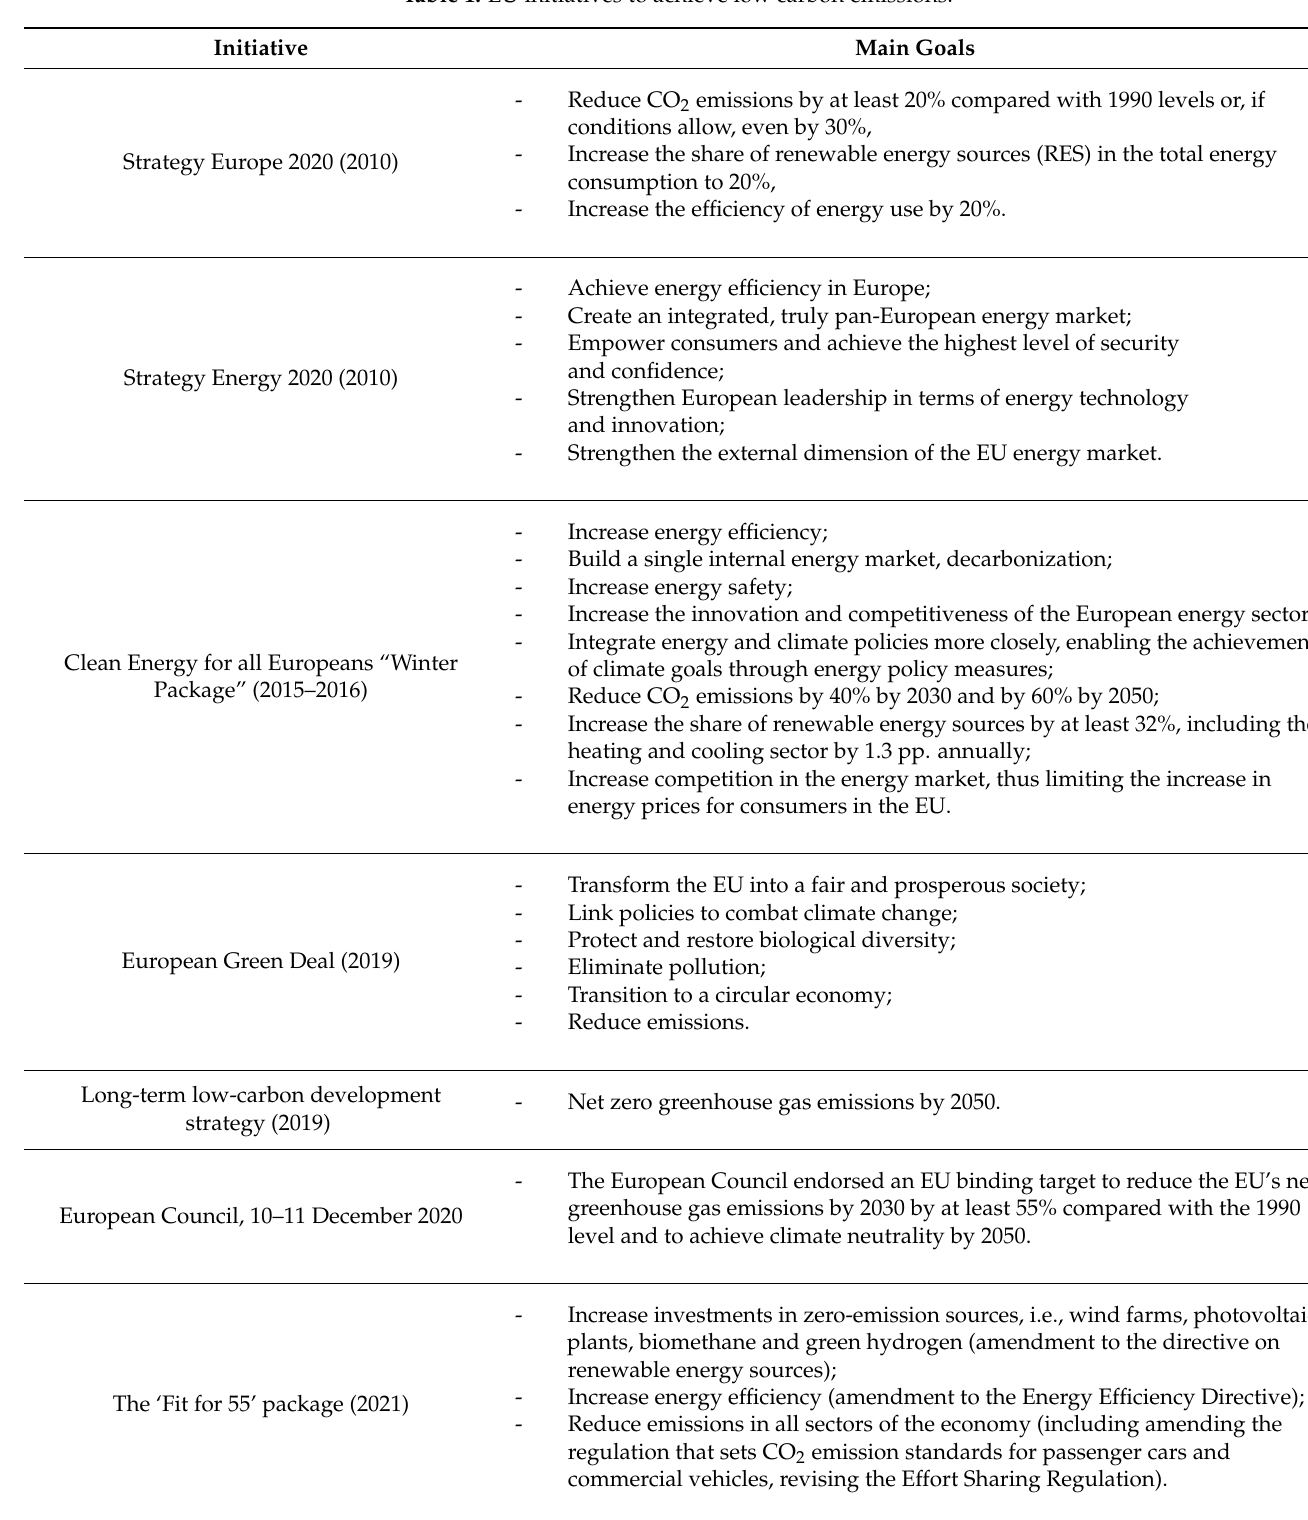
Table 1. EU initiatives to achieve low carbon